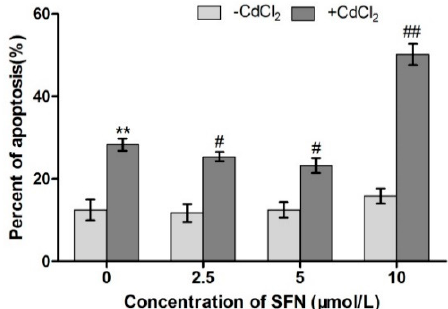
Figure 7. Detection of cell apoptosis using FITC Annexin V/PI double-labeling (%). ** represents an extremely significant difference, compared with the control group. # and ## represent a significant and an extremely significant difference, respectively, compared with the Cd group.